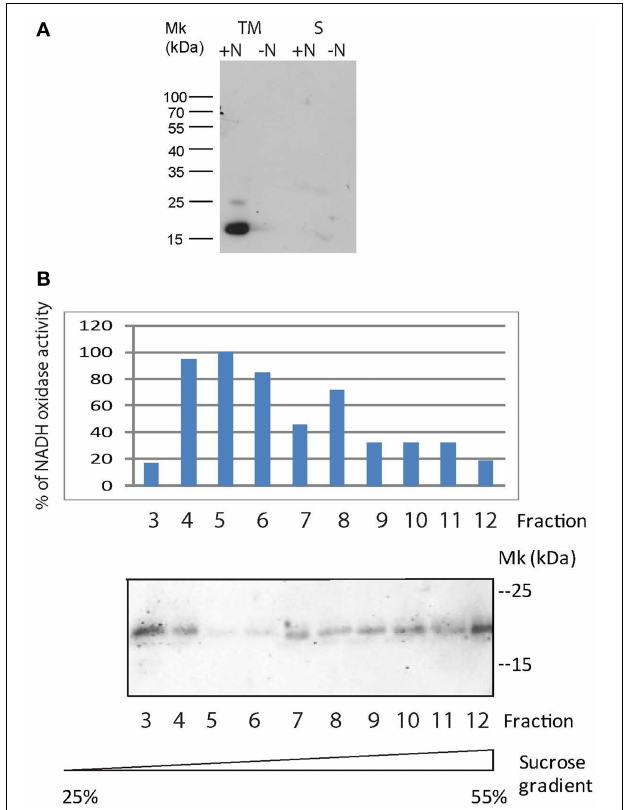
FIGURE 4 | Expression and localization of the 3x FLAG Y4yS fused protein. (A) Total membranes (TM) and fractions corresponding to the cytoplasm and periplasm (S) of the MAFF303099 strain with sequence encoding the 3xFLAG Y4yS fused protein integrated into the bacterial chromosome. The two bacteria contain plasmid pMP2112. Proteins were separated by 10 % SDS-PAGE and then immuno-blotted and probed with an anti-FLAG antibody. Positions of size markers loaded onto the gels are labeled (in kDa). ± N indicate bacterial culture in the presence or absence of naringenin. (B) Subcellular localization of Y4yS-FLAG expressed from a pBBR1MCS-4 plasmid into an y4yS mutant strain was determined by sucrose density gradient centrifugation. Inner and outer membranes were fractionated as described in Materials and Methods. Fractions were collected as 1-ml aliquots from the top of a discontinuous sucrose gradient. Fractions enriched in the inner membranes were identified by monitoring NADH oxidase activity. Enzyme activity was expressed as percentage of maximal activity. Y4yS-FLAG was detected by immunobloting with anti-FLAG (from mouse) and fluorescent anti-mouse antibodies. Bacteria contain plasmid